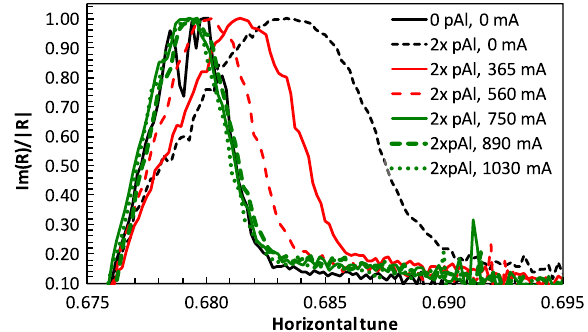
FIG. 17. Tune distribution width reduction with the electron lens, measured in the proton beam with p þ Al collisions. The distribution widens due to two beam-beam interactions, and narrows again with the electron lens. The curves are aligned to the left with an offset for better visibility of the effect.